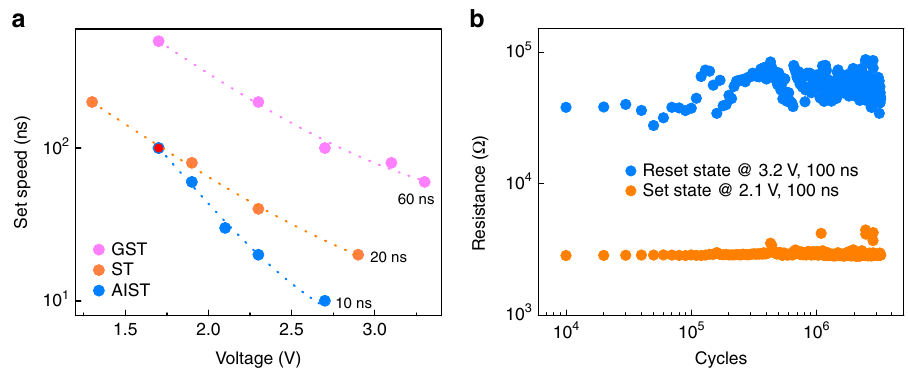
Fig. 7 Device performance of optimized AIST (Ag 2.31 In 4.56 Sb 61.27 Te 31.86 ) device. a set operation speed of GST, ST and optimized AIST-based devices. Optimized AIST presents the highest operation speed, 10 ns, comparable to DRAM. b endurance performance of optimized AIST device. The cells can be repeatedly operated over 2 million